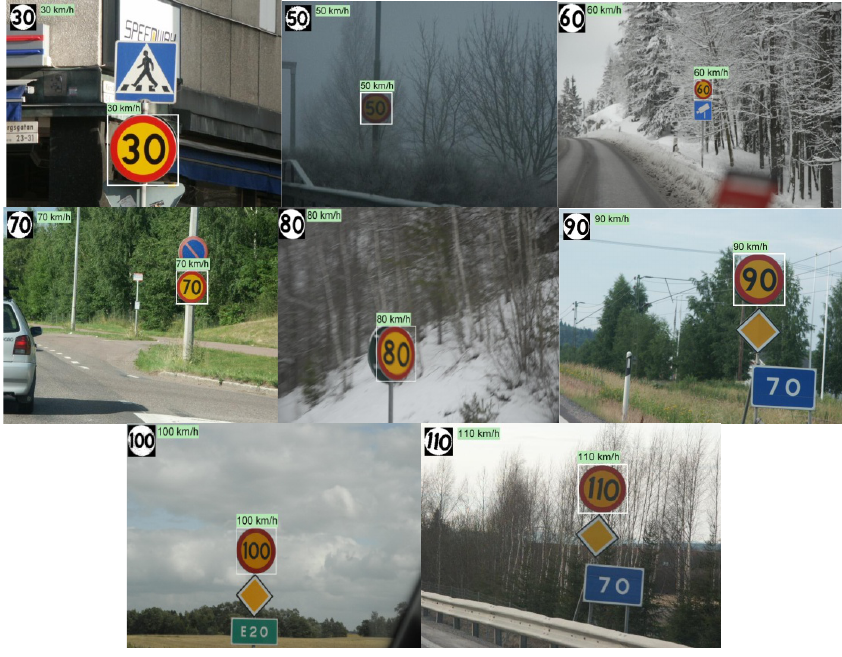
Figure 7. Correctly classified speed limit traffic